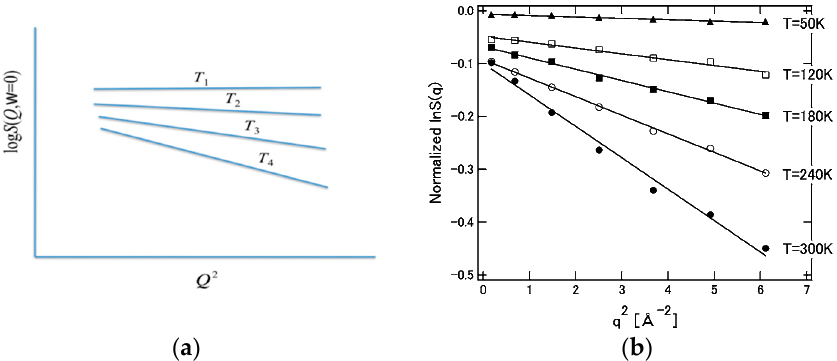
Figure 13. Wave number and temperature dependence of neutron structure factor. ( a ) Theoretical prediction: T 1 < T 2 < T 3 < T 4 . ( b ) Experimental data Ref. [100]. ((a) is reprinted from Ref. [25]. Copyright (2018) Elsevier. ( b ) is reprinted from Ref. [100]. Copyright (2008) Elsevier.).